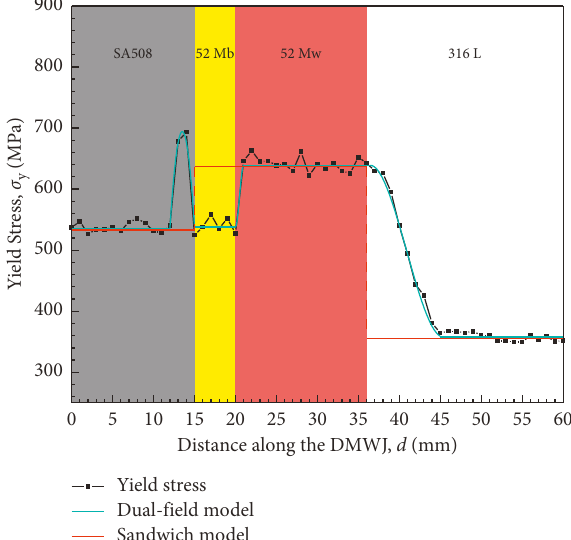
Figure 5: Yield strength distribution of sandwich model and dual- field model of the